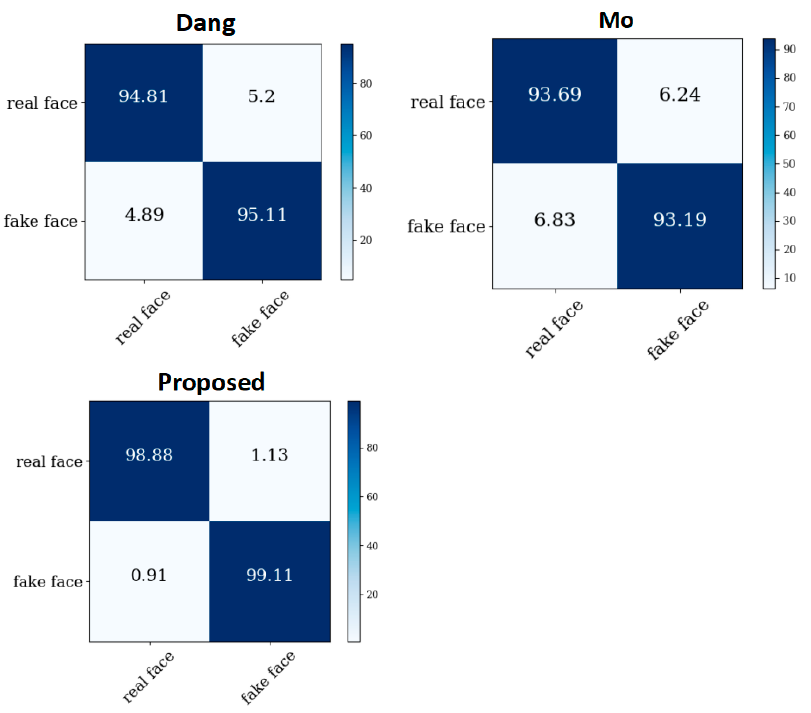
Figure 9. The confusion matrix performances of the three models on GS128 and C128.